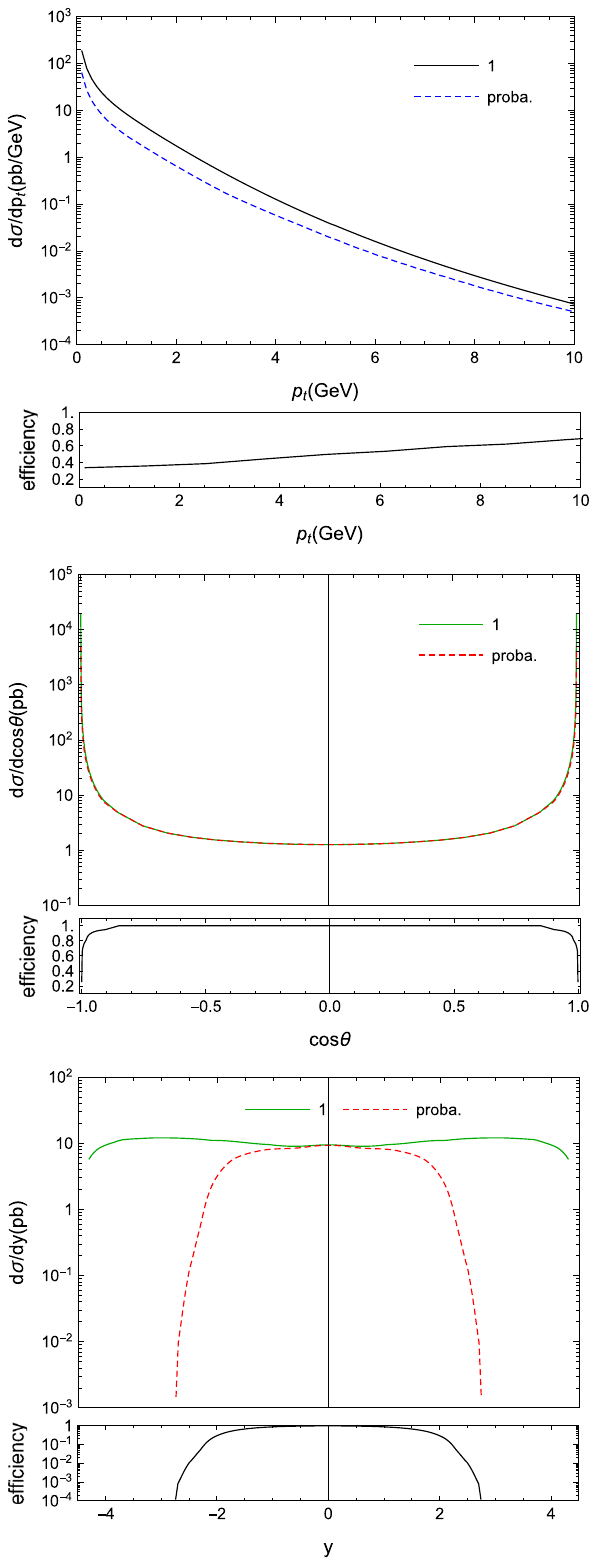
Fig. 6 The kinematic distributions of prompt J /ψ photoproduction before (line-1) and after (line-proba.) considering the detection effi- ciency. The curves in the flat frames are the corresponding